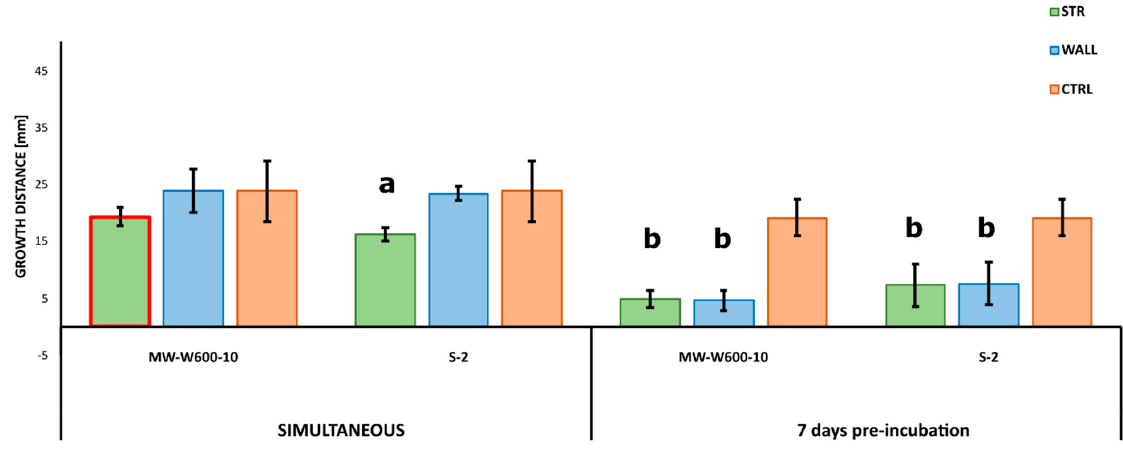
Figure 5. Different effects of Streptomyces sp. MW-W600-10 and Streptomyces sp. S-2 on the growth of F. culmorum DSM62188 in co-cultures — simultaneous and with bacteria pre-incubated for 7 days. The charts compare the growth of fungal mycelium toward Streptomyces streak colonies (STR), the plate wall (WALL), and fungal growth on control plates (CTRL) for co-cultures with Streptomyces inoculated at a 25 mm distance from the center of the plate. Results are shown for the 3rd day of co-culture. For each experimental setup, 5 biological repeats were performed for co-cultures and 3 repeats for controls. The red border of the bars indicates the fungus reaching the plate wall or bacterial streaks by the day of measurement. Error bars represent the standard deviation of mycelial growth in independent biological experiments. Statistically significant differences between measurements analyzed for each experimental setup separately are marked by the (a) difference between all measurements or by the (b) difference between the measurement and CTRL only (one-way ANOVA, followed by Tukey’s post hoc test; p ≤ 0.05).